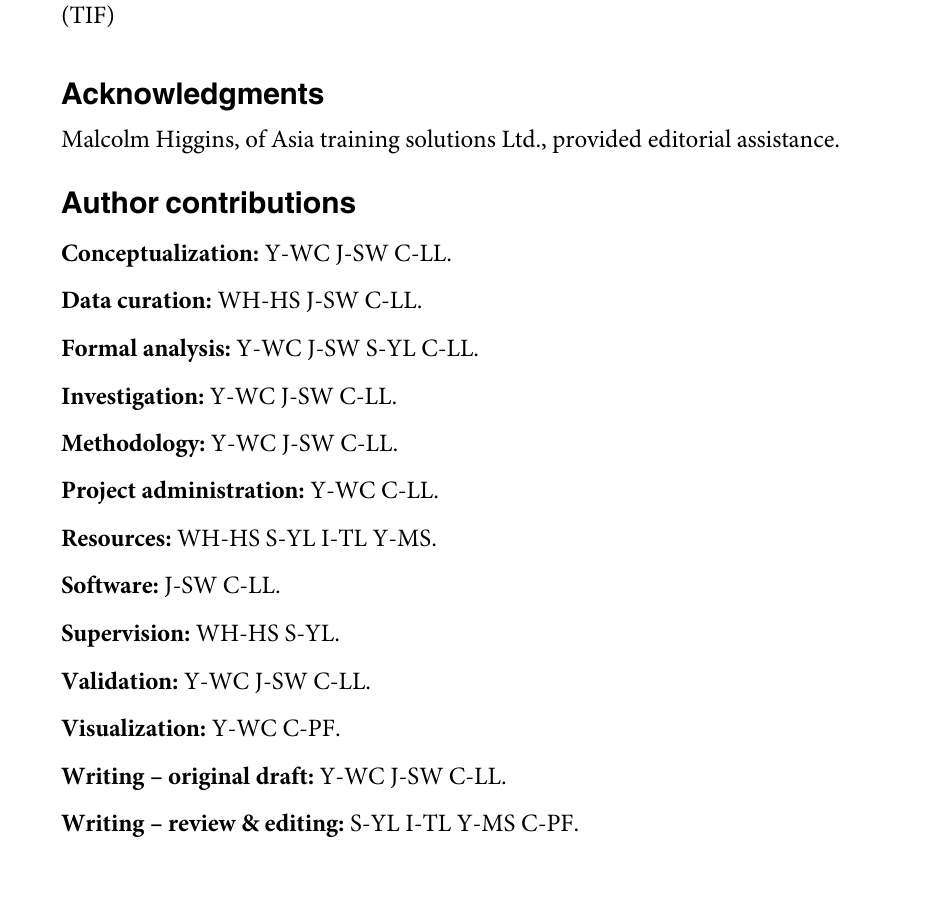
S1 Fig. Scatter plot of correlation between estimated HbA1c and observed HbA1c. S2 Fig. Scatter plot of correlation between residual value and observed HbA1c. Residual value = estimated value of HbA1c (%) minus observed value of HbA1c (%)